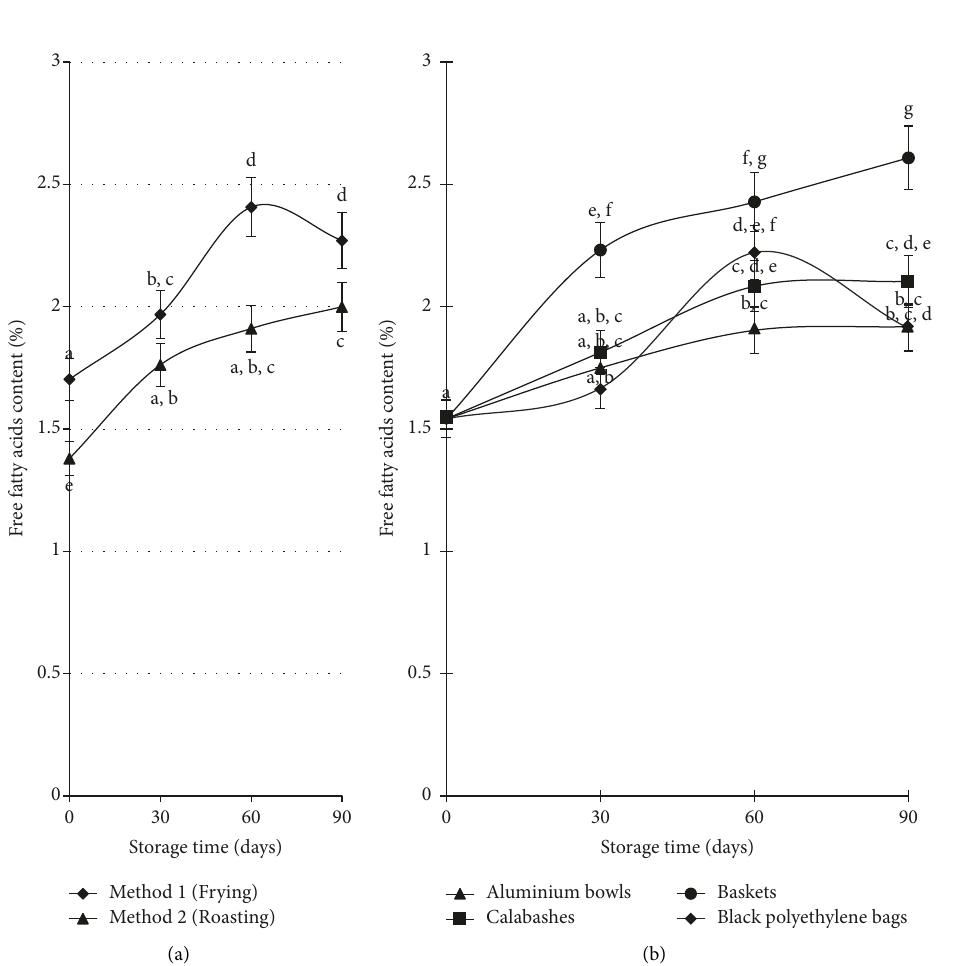
Figure 3: Effect of the production method (a) ( n � 12) and packaging material (b) ( n � 6) on free fatty acid of Pentadesma butter during